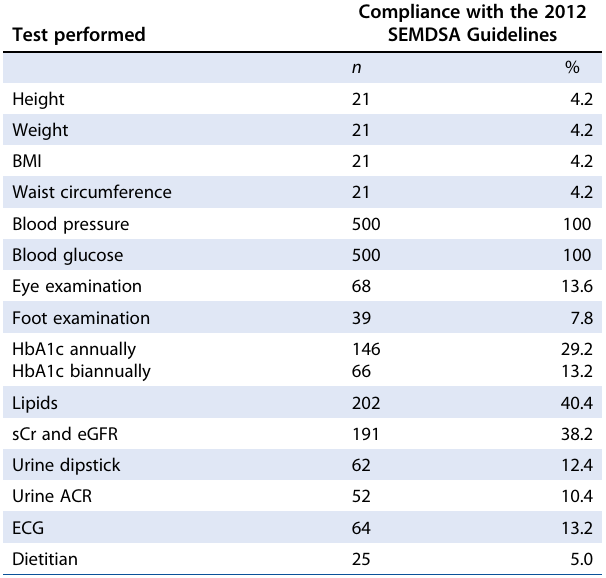
Table 4: Relationship between age and tests Compliance with the 2012 SEMDSA Guidelines